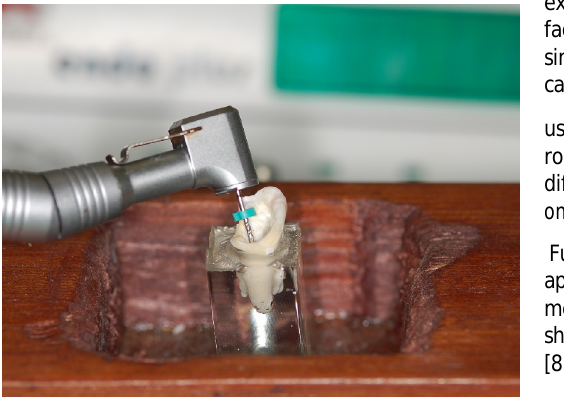
Figure 4: Rotary instrumentation with K3 Rotary System ®.